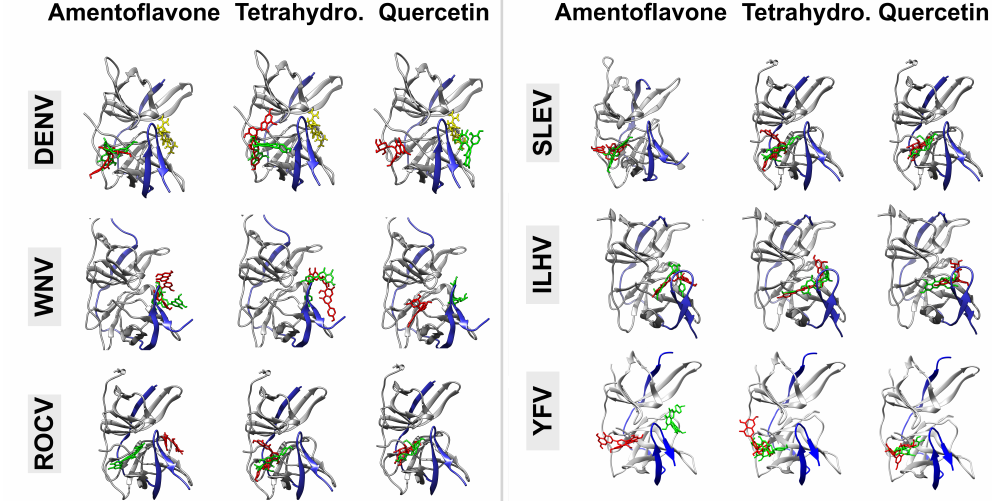
Figure 8. Representation of the binding modes of molecules in NS2B–NS3pro proteins in dengue virus (DENV), West Nile virus (WNV), Rocio virus (ROCV), Saint Louis encephalitis virus (SLEV), Ilhéus virus (ILHV), and yellow fever virus (YFV). The allosteric and active sites are on the right and left of NS2B (blue ribbon). ILHV NS2B–NS3 is only represented by Cluster 1. Cluster 2 is shown in Figure